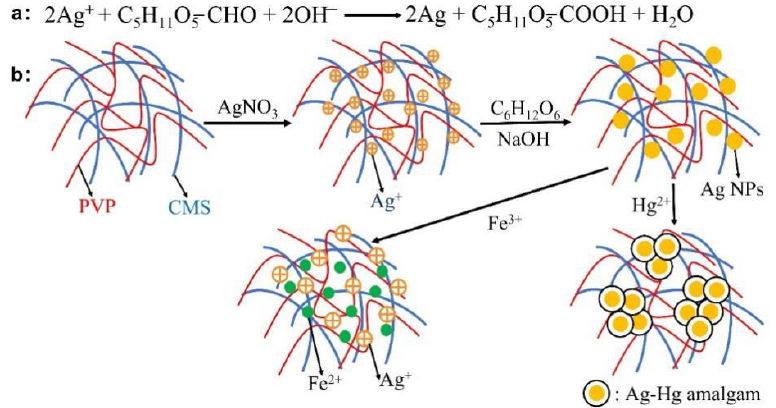
Figure 8. ( a ) Reaction equation of AgNO 3 and Glucose; and ( b ) Reaction scheme of the synthesis of Ag NPs and the interaction between Ag NPs and Hg 2+ ions or Fe 3+ ions.